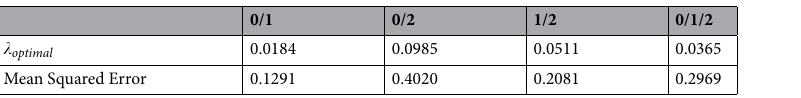
Table 2. Optimal lambda ( (cid:31) optimal ) and Mean Squared Error for each group comparison.